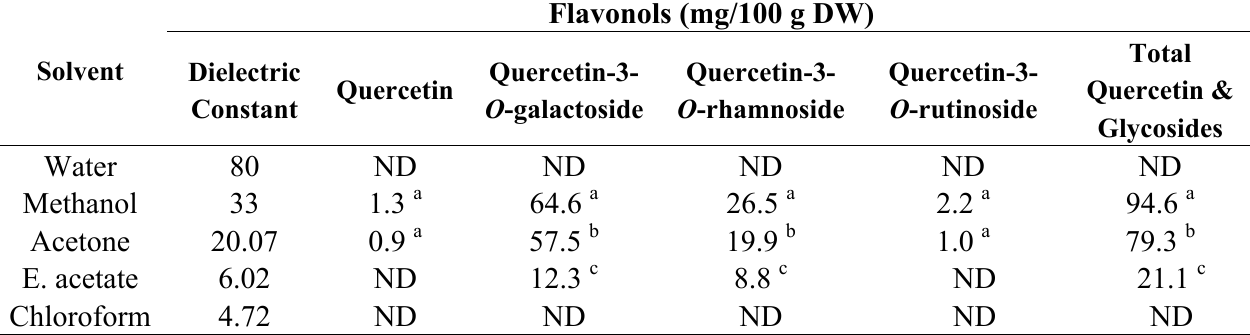
Table 1. Effect of extraction solvents of varying polarity on the recovery of selected flavonols from dehydrated apple peels a